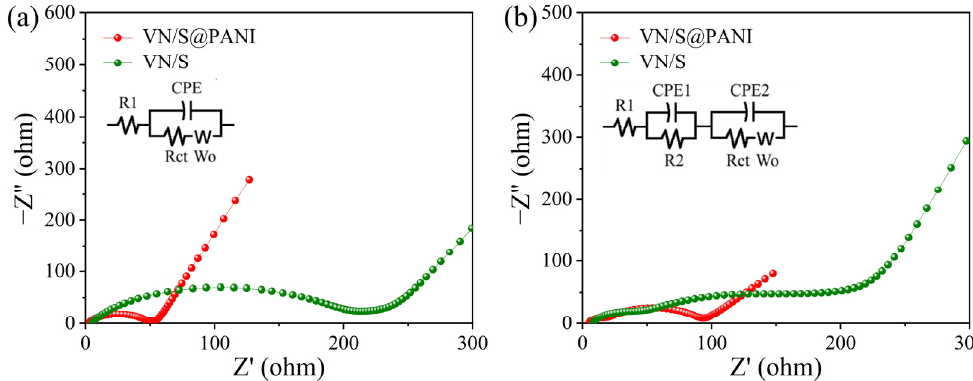
Figure 11. EIS plots and corresponding equivalent circuits of VN/S microrod and VN/S@PANI microrod cathodes ( a ) before the cycling test and ( b ) after 500 cycles.